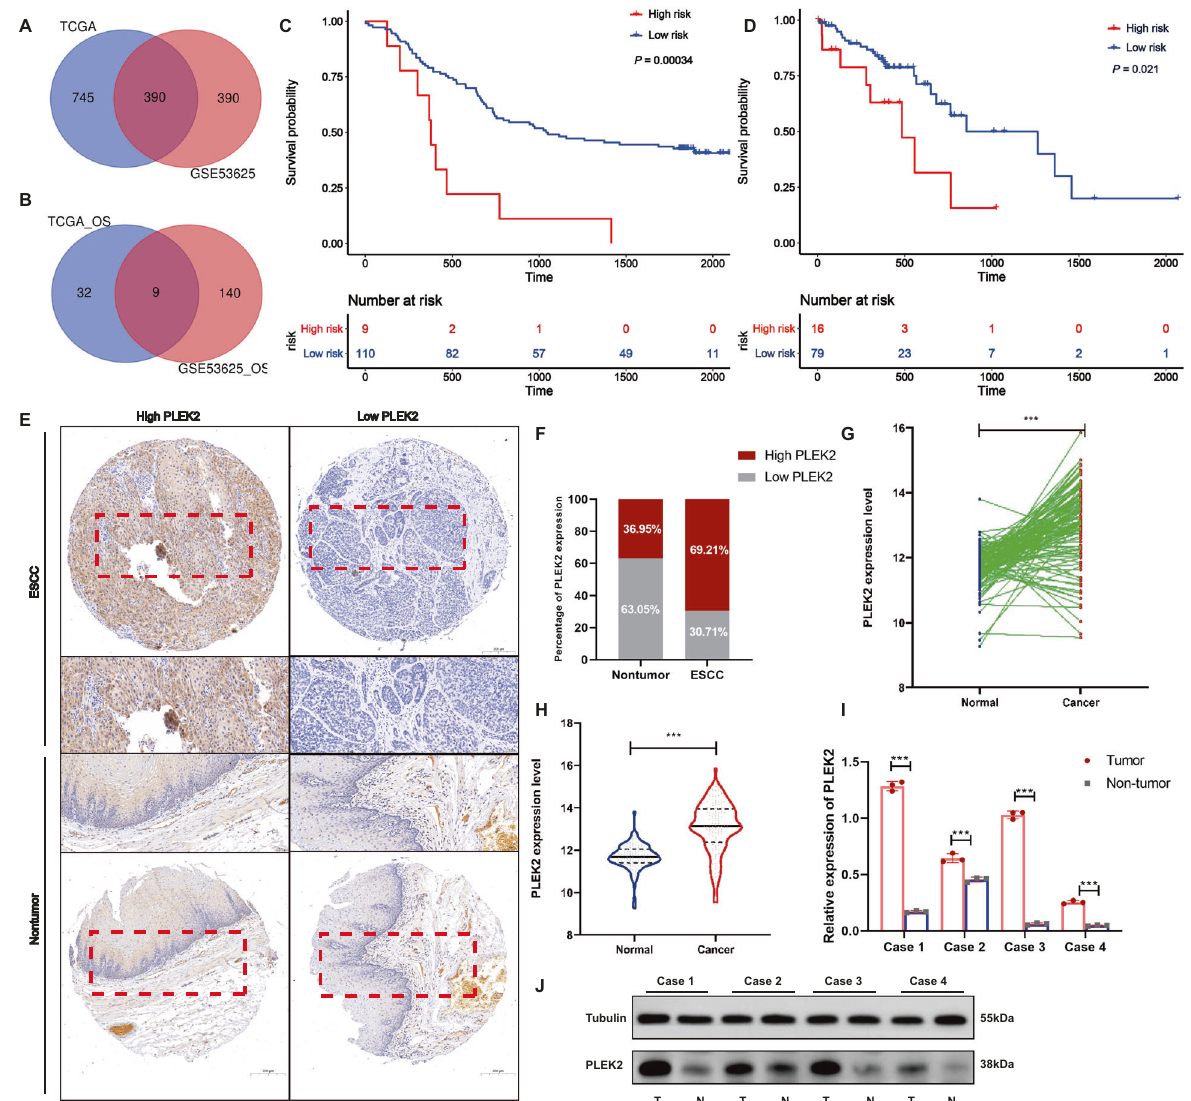
Fig. 1 PLEK2 is overexpressed in ESCC and associated with prognosis. A Venn diagram of common differentially expressed genes in the TCGA and GSSE53625; B Venn diagram of common genes which were related to OS in the TCGA and GSSE53625; C Kaplan – Meier plots of OS of patients with ESCC in GSE53625, P = 0.00034; D Kaplan – Meier plots of OS of patients with ESCC in TCGA database, P = 0.021; E PLEK2 expression in a human ESCC tissue microarray. Representative microscopic images of benign and ESCC tissues stained with an antihuman PLEK2 antibody; F Bar chart summary of the distribution of PLEK2 expression levels in nontumor versus ESCC by IHC ( n = 100 total cases; * P < 0.05); G The expression of PLEK2 in tumour tissues and nontumor tissues in the GSE53625 database when the data were not paired, *** P < 0.001; H The expression of PLEK2 in tumour tissues and nontumor tissues in the GSE53625 database when the data were paired, *** P < 0.001; I Relative expression of PLEK2 in fresh tumour tissues and adjacent normal tissues from four ESCC patients detected by Western Blot. *** P < 0.001; J Expression of PLEK2 in fresh tumour tissues and adjacent normal tissues from four ESCC patients detected by Western Blot. Tubulin was used as loading